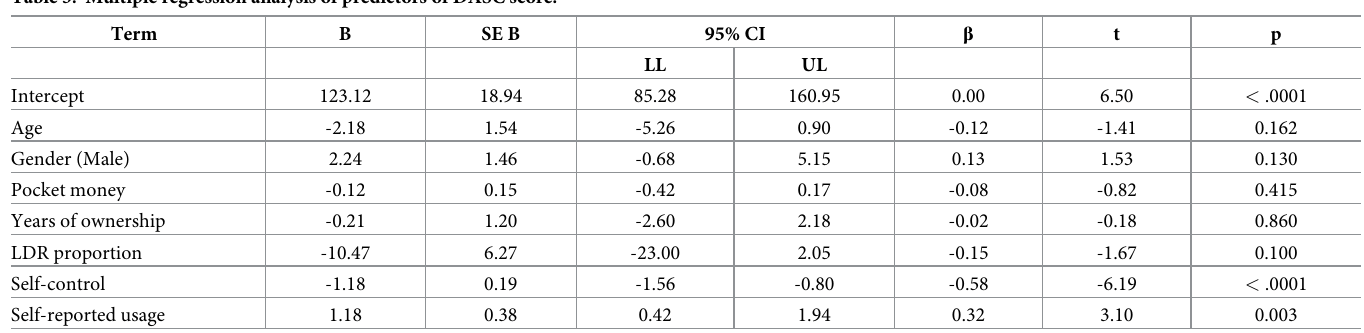
Table 3. Multiple regression analysis of predictors of DASC score.